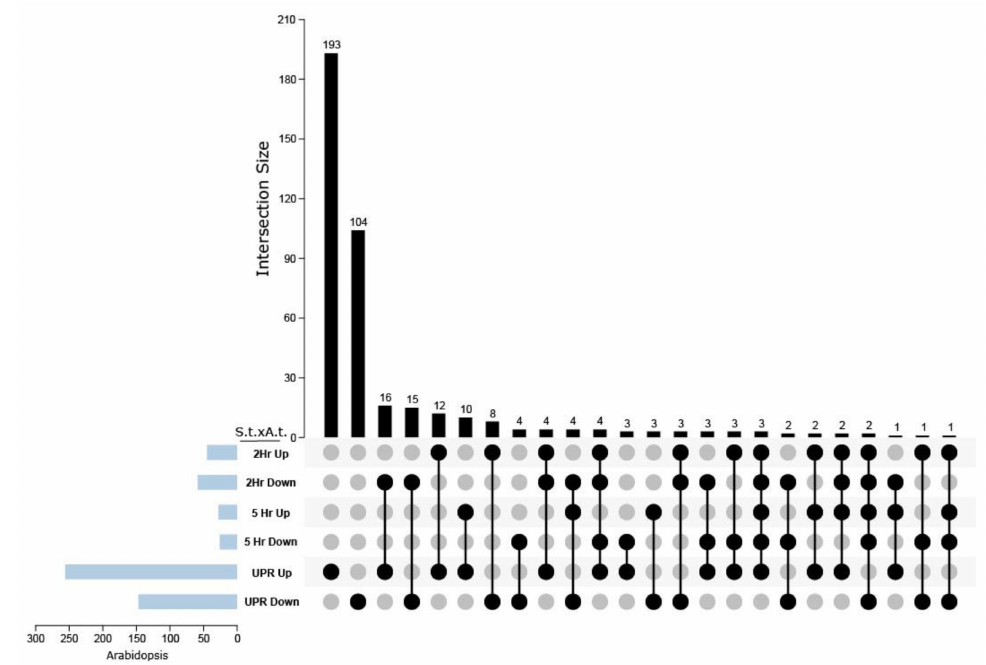
Figure 6. UpSet plot displaying the comparative analysis between UPR-related DEGs in Arabidopsis and potato leaves in response to TM treatment. The UpSet plot shows potato DEGs (2 and 5 h) that were also represented in a published Arabidopsis UPR DEGs dataset obtained following induction by TM. S.t . x A.t. is shorthand for S. tuberosum by A. thaliana comparison of